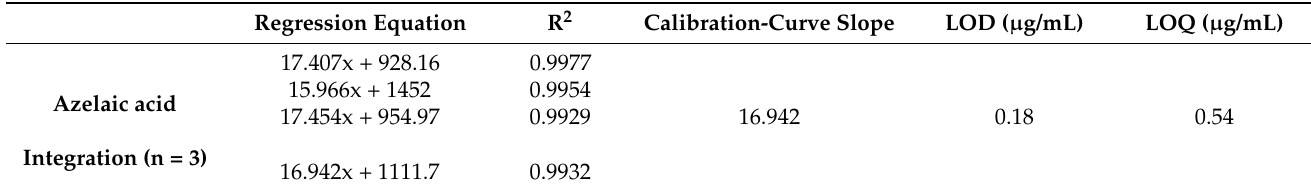
Table 1. Results of linearity regression, correlation coefficient, LOD, and LOQ for AzA. Regression Equation R 2 Calibration-Curve Slope LOD ( µ g/mL) LOQ ( µ